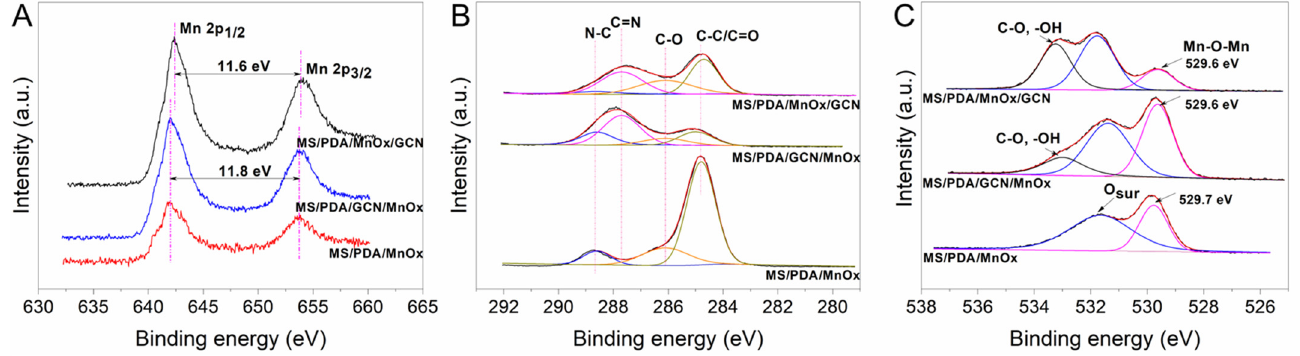
Figure 5. XPS spectra of the catalysts MS/PDA/MnOx, MS/PDA/GCN/MnOx and MS/PDA/MnOx/GCN: ( A ) Mn 2p; ( B ) C 1s; ( C ) O 1s.